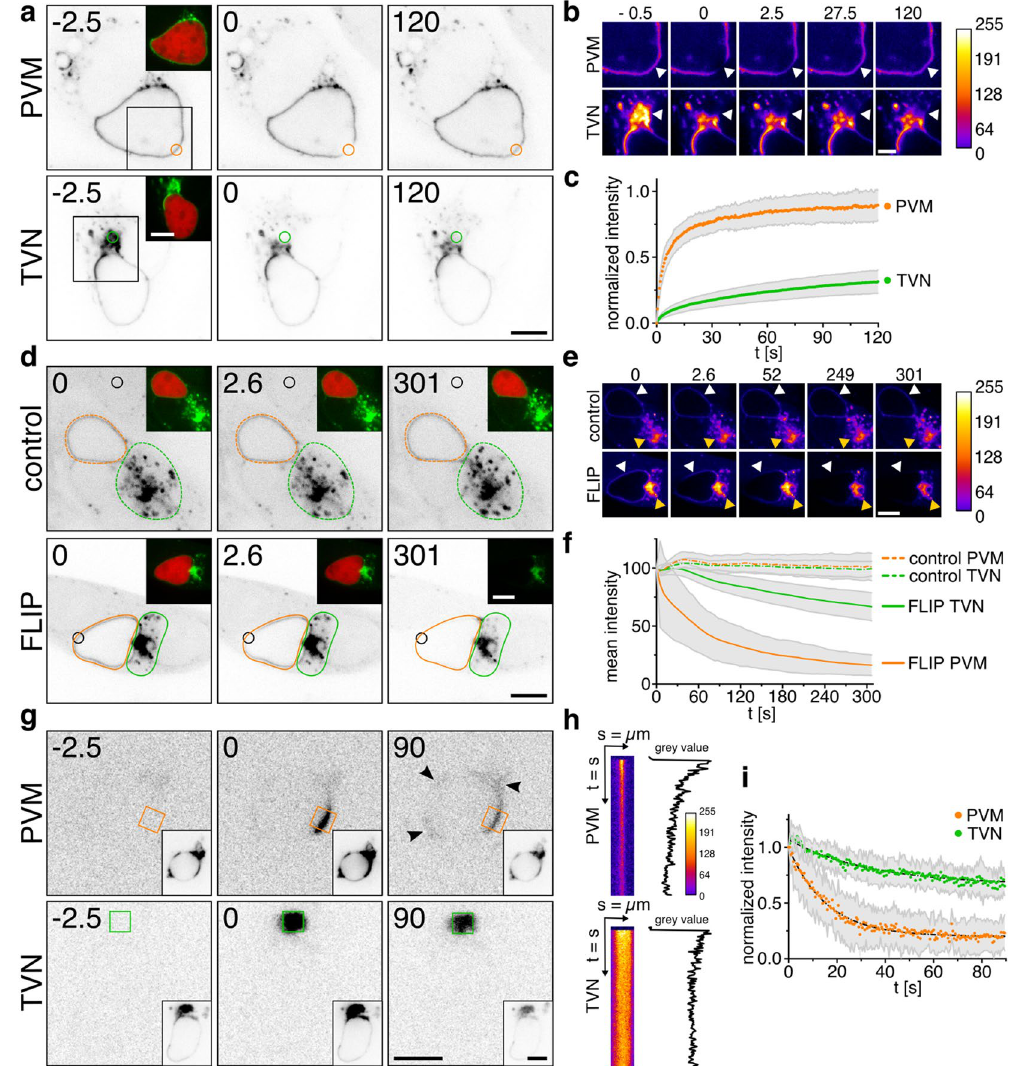
Figure 3. Compartment-specific LC3 mobility reveals trapping of LC3 in the TVN. (a–c) Fluorescence Recovery After Photobleaching (FRAP) of GFP-LC3 HeLa cells infected with Pb mCherry 33-36 hpi. Fluorescence recovery reveals a distinctive LC3 motility at the PVM (orange ROI) versus TVN (green ROI). (b) Pseudo-coloured heat maps visualizing the dynamics of LC3-recovery at the bleached area (arrowhead). (c) FRAP-quantification at the PVM (orange) and the TVN (green) (n = 40; mean ± s.d.). (d–f) Fluorescence Loss In Photobleaching (FLIP) shows loss of LC3 at the PVM and retention at the TVN. (d) Repetitive bleaching (black ROI) performed on an adjacent, uninfected GFP-LC3 cell for imaging-induced fluorescence decay (control), or on PVM-localized LC3 (FLIP). Mean fluorescence intensity of GFP-LC3 measured around PVM (orange ROI) and TVN (green ROI). (e) Pseudo-coloured heat maps of GFP-LC3 intensity at the PVM (white arrowhead) or TVN (yellow arrowhead). (f) FLIP-quantification at the PVM (orange) and TVN (green) (n = 40; mean ± s.d.). (g) Photoconversion of Dendra2-LC3 at the PVM (orange ROI) or TVN (green ROI) showing pre-activation, post-activation and final image of young schizonts (24 hpi, Pb wt). Insets display the green channel (non-converted Dendra2-LC3). Arrowheads point out the re-distribution of converted Dentra2-LC3 at the PVM. (h) Representative, pseudo-coloured kymograph of activated LC3 in (g) measured at ROI. (i) Quantification of LC3 at the PVM (orange) and TVN (green) based on kymographs (n = 10; mean ± s.d.). Time stamps in s. Scale bars, 10 µ m (a, d, g) and 5 µ m (b, e)